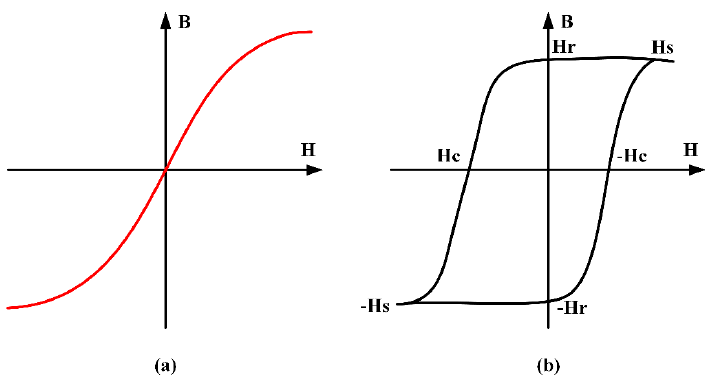
Figure 1. ( a ) BH -Loop of a soft magnetic material; ( b ) BH -Loop of a hard-magnetic